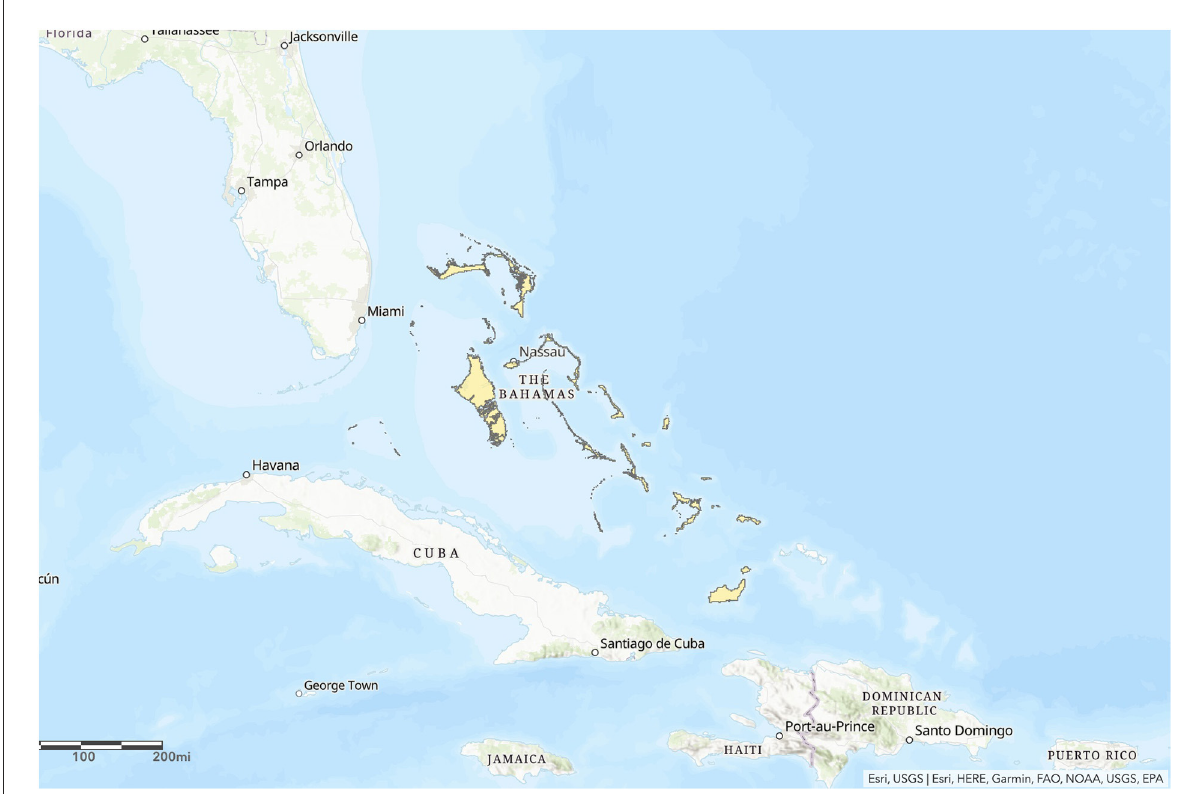
FIGURE1 Location of the archipelago of The Bahamas and Nassau, New Providence. Andros, the source of barged water, is the large island located to the west of New